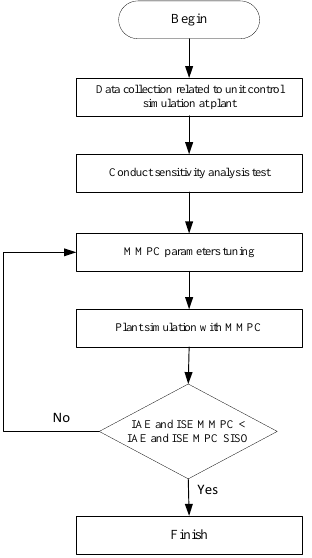
Figure 1. Research flowchart